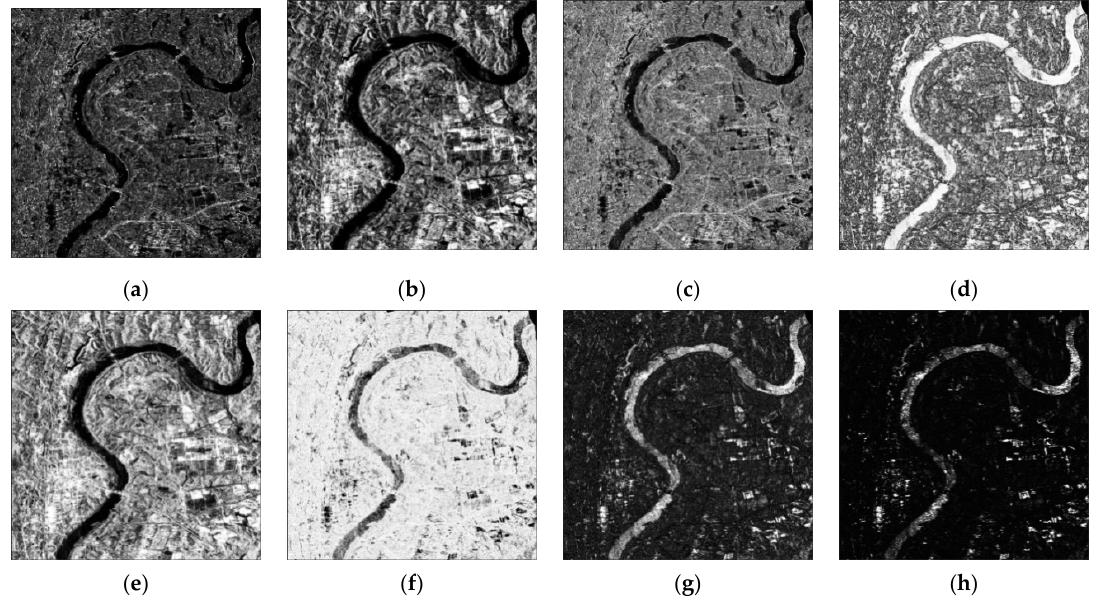
Figure 9. Texture features of ALOS-2. ( a ) Contrast; ( b ) variance; ( c ) dissimilarity; ( d ) angular second moment; ( e ) mean; ( f ) entropy; ( g ) homogeneity; ( h ) correlation.